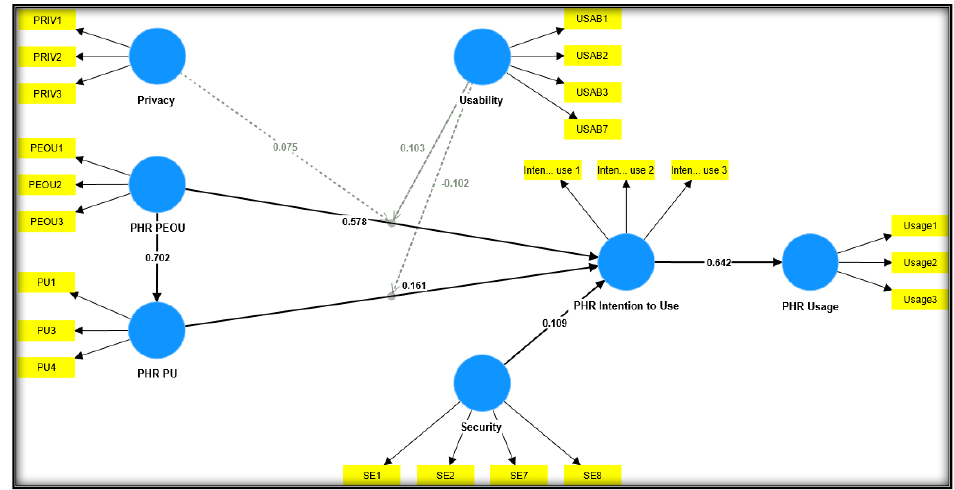
Figure 1. Research Model.